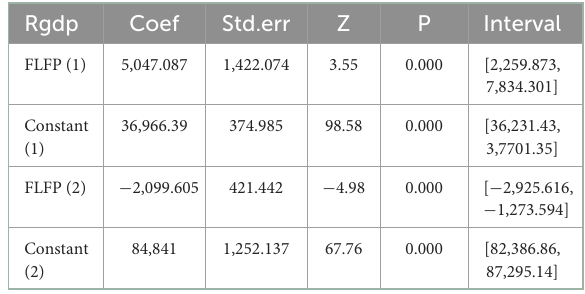
TABLE 4 Threshold measurement